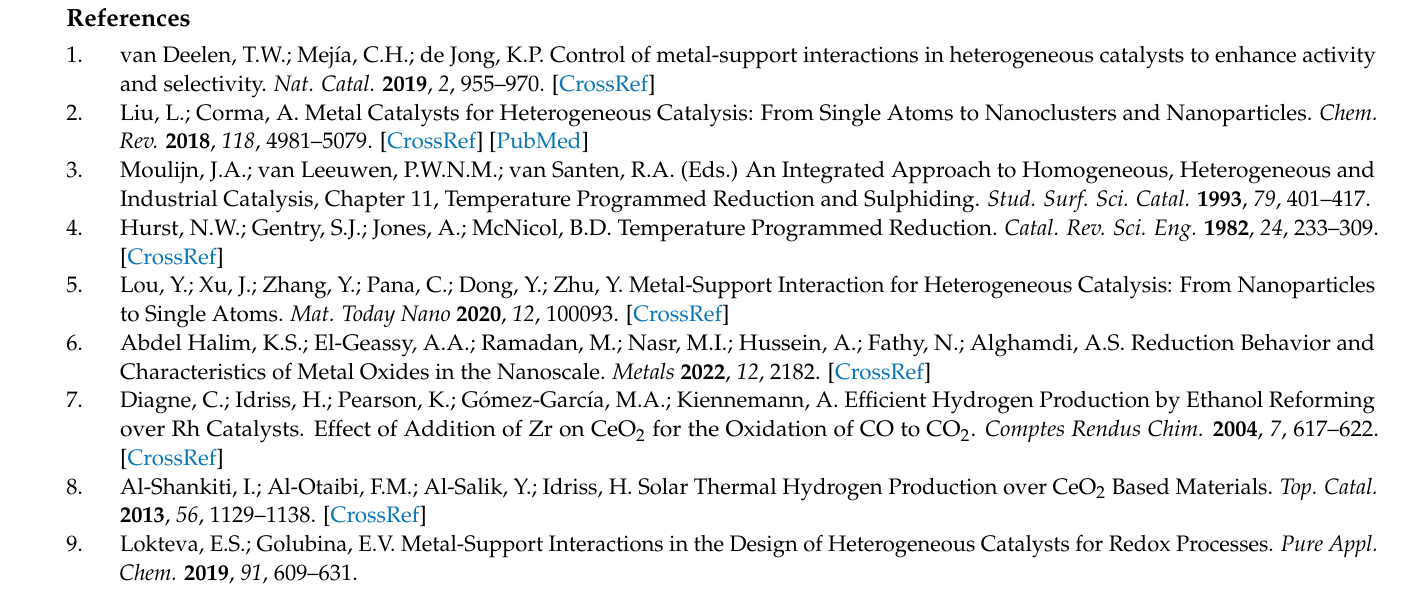
IrO 2 /TiO 2 ; Figure S2: Fitted experimental data and calculated (d α /dT) using different reduction models; Figure S3: XRD of 3.5 wt.% IrO 2 /TiO 2 annealed at 400 ◦ C and 600 ◦ C; Figure S4: XRD of Figure S5: Deconvoluted experimental data for the second reduction step during